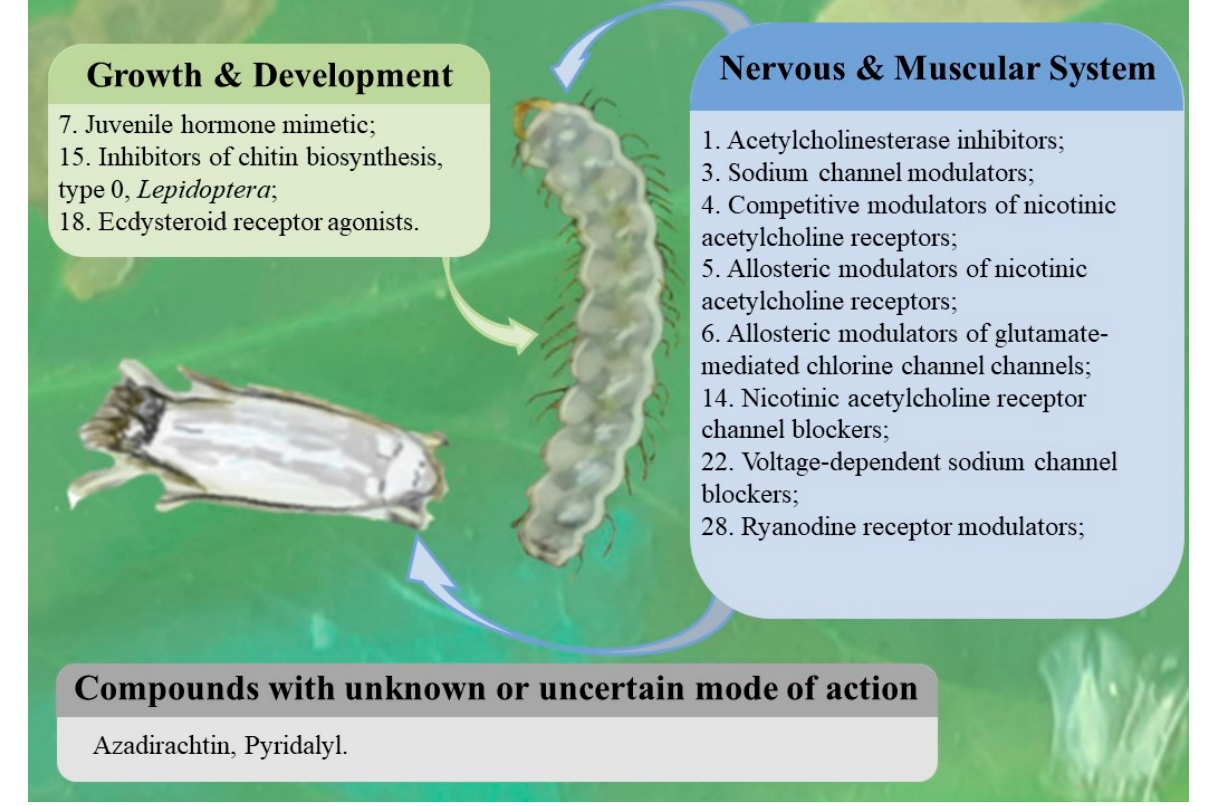
Figure 8. Main chemical products to control the CLM registered at the Brazilian Ministry of Agriculture, Livestock and Supply (MAPA), to control L. coffeella , (Supplementary Table S1) categorized by their action mode in squares with different colors: green—insecticides that affect the growth and the development; blue—insecticides that affect the nervous and the muscular system; grey—action modes not determined. The action mode is categorized by numbers, showing the specific action site of the product.